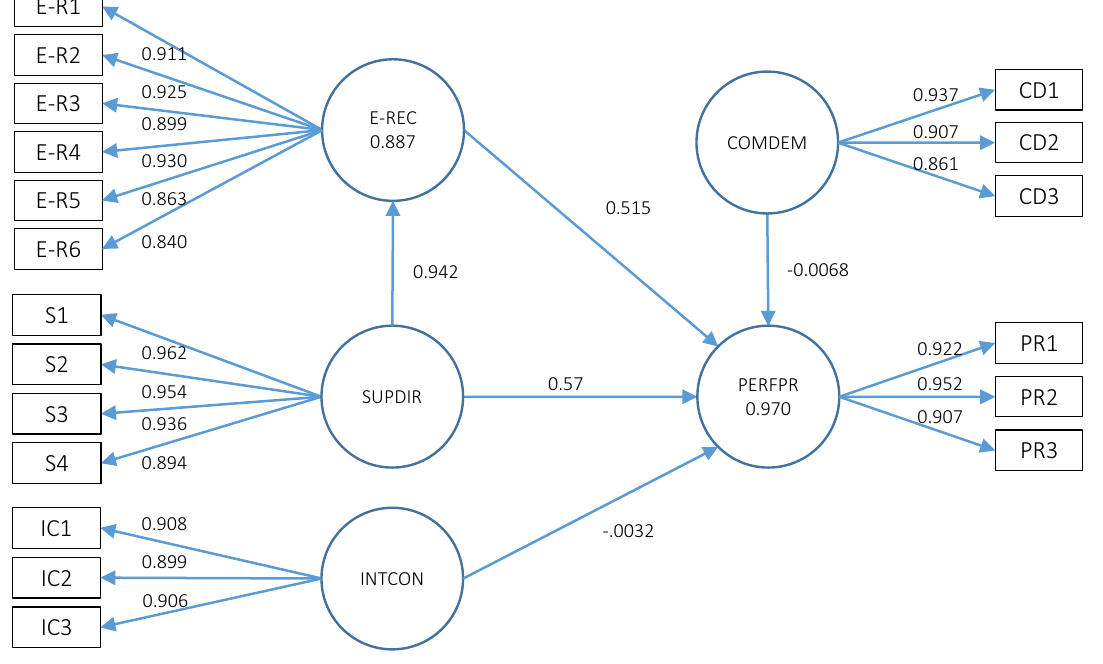
Figure 2. Measurement models, factor loadings, and coefficient